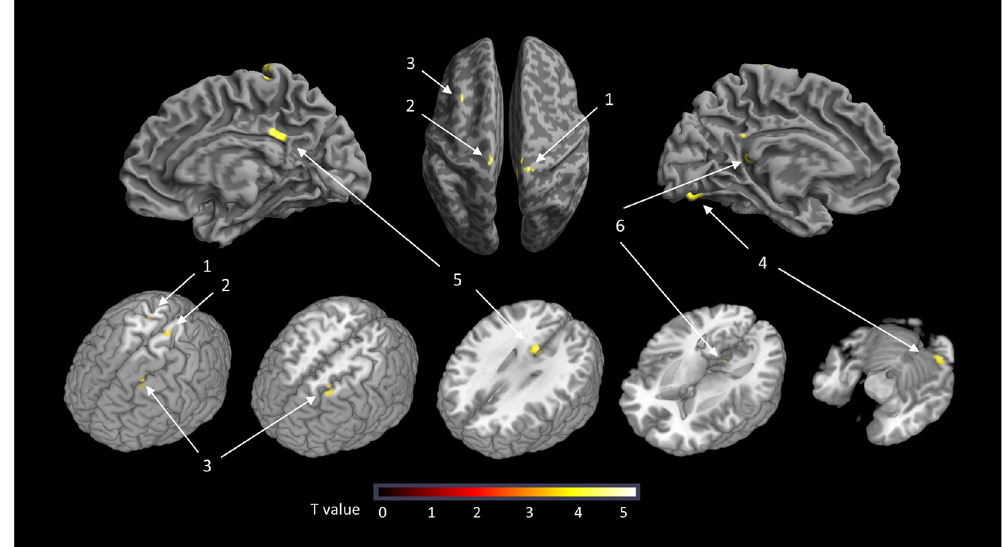
Figure 2. Brain areas showing a higher BOLD signal on response to SS in the PI versus GS group 1: Right precentral cortex 2: Left precentral cortex. 3: Left prefrontal cortex. 4: Left fusiform cortex. 5: Right posterior cingulate cortex. 6: Left posterior cingulate cortex. Note: BOLD response to SS was calculated by subtraction of the BOLD response to NS from that to SS (SS-NS).